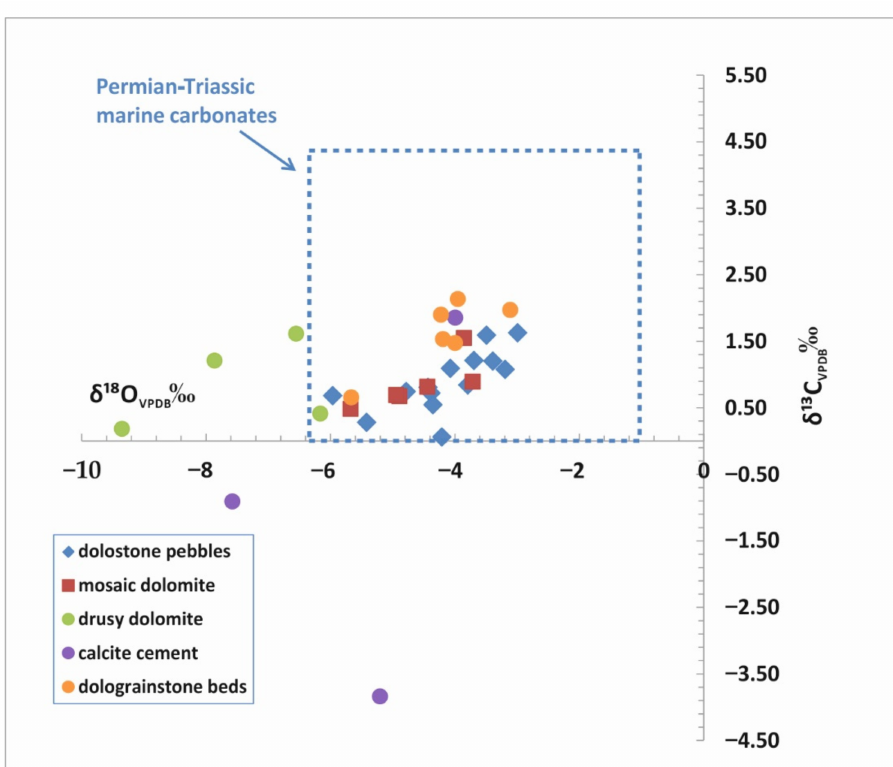
Figure 7. Cross plot of stable δ 13 C VPDB versus δ 18 O VPDB values of samples from the conglomer- ate/breccia beds and the dolograinstone beds in the conglomerate/breccia interval, as well as isotope values of Permian to Triassic marine carbonates. Stable oxygen isotope values of drusy dolomite are lower compared to other dolomites and slightly lower than sea coeval marine